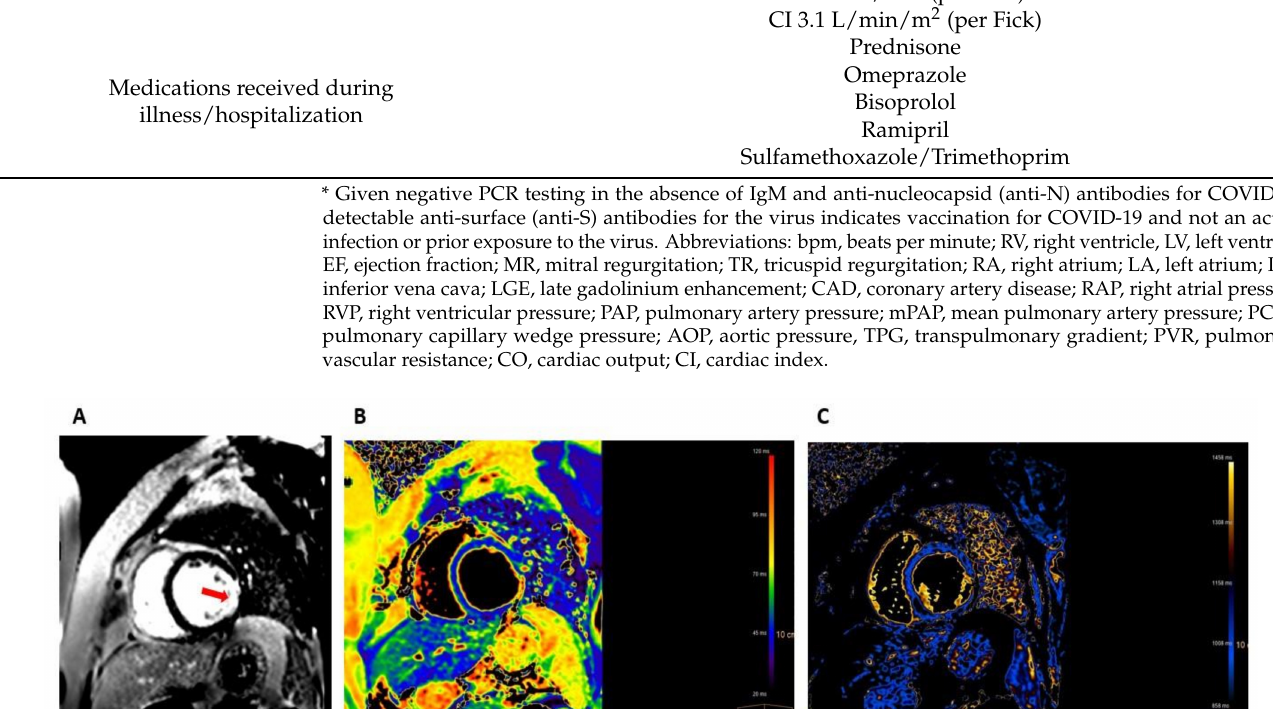
3.1 L/min/m 2 . An endomyocardial biopsy specimen taken form the right ventricle